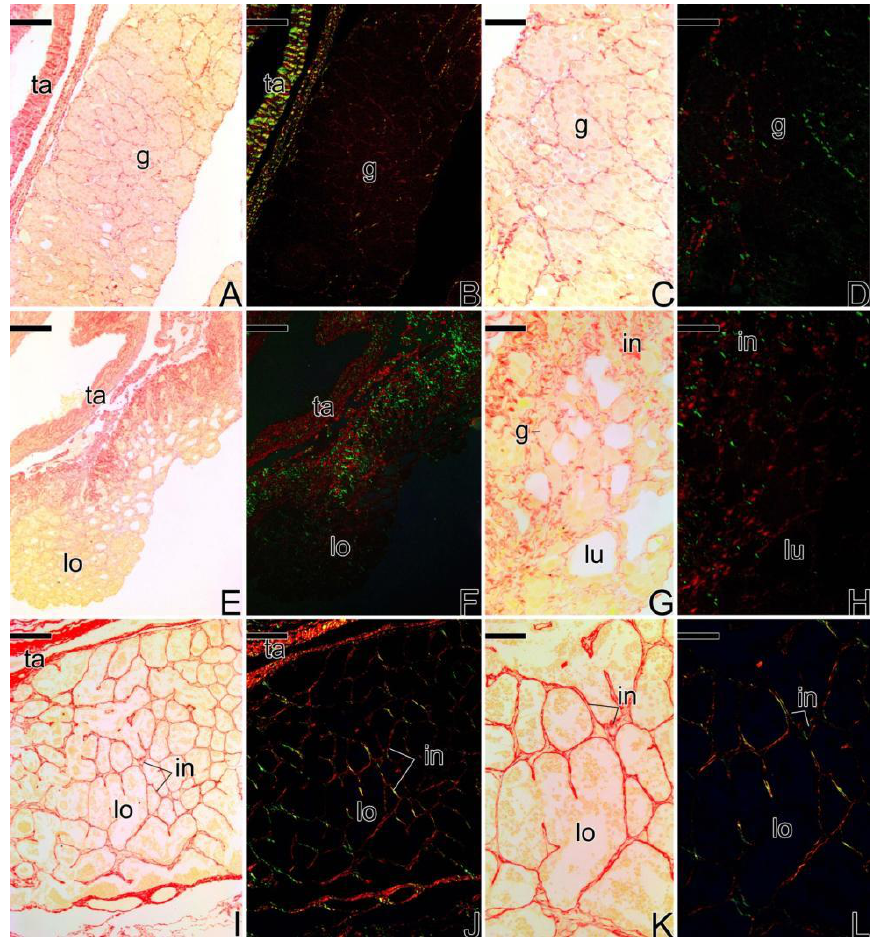
Figure 14. Histological sections of the stages of testicular development of primary males of S. marmoratus . Picrosirius Red staining. ( A , C , E , G , I , K ) unpolarized light. ( B , D , F , H , J , L ) polarized light.( A – D ) Testis at the beginning of the development, with germinal epithelium formed only by spermatogonia. ( E – H ) Testis with germinal epithelium formed by cysts of spermatogonia, spermatocytes, and spermatids. There is no production of spermatozoa yet. The collagen fibers of the interstitium are more intense than the previous stage. ( I – L ) Testis of primary male capable of reproducing, showing the tunica albuginea defined. In the interstitial compartment, the collagen fibers are quite organized and defined. Tunica albuginea (ta), spermatogonia (g), interstitium (in), testicular lumen (lu), testicular lobule (lo). Staining: Sirius red (red) and Picric Acid (yellow). Bar: 100µm ( A , B , I , J ), 50μm ( C , D , G , H , K , L ), 150μm ( E , F ).